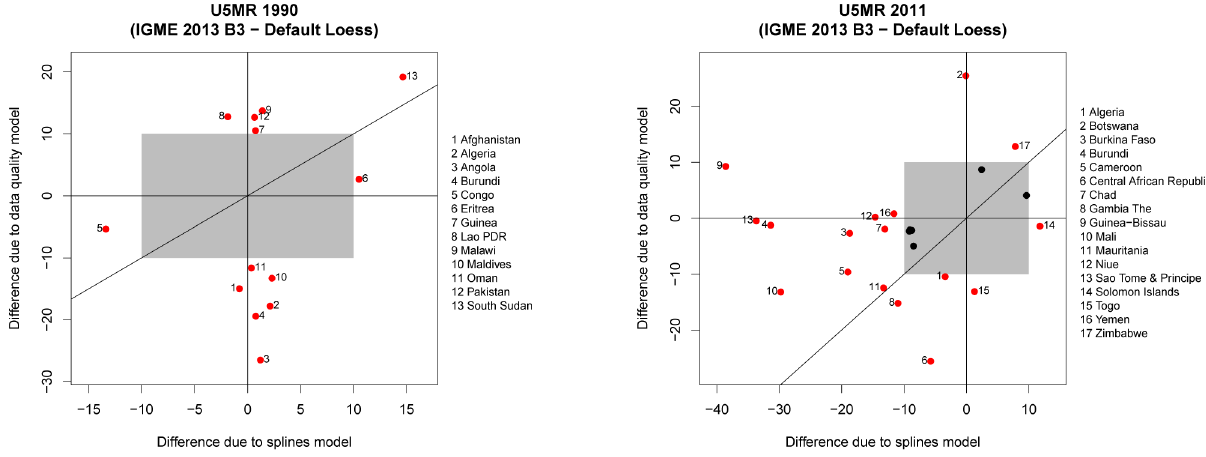
Figure 6. Decomposition of differences in U5MR for 1990 and 2011 into differences due to data quality model and differences due to splines model. The gray box represents differences up to 10 deaths per 1,000 live births. Countries with differences of more than 10 deaths per 1,000 deaths due to either factor are highlighted in red.